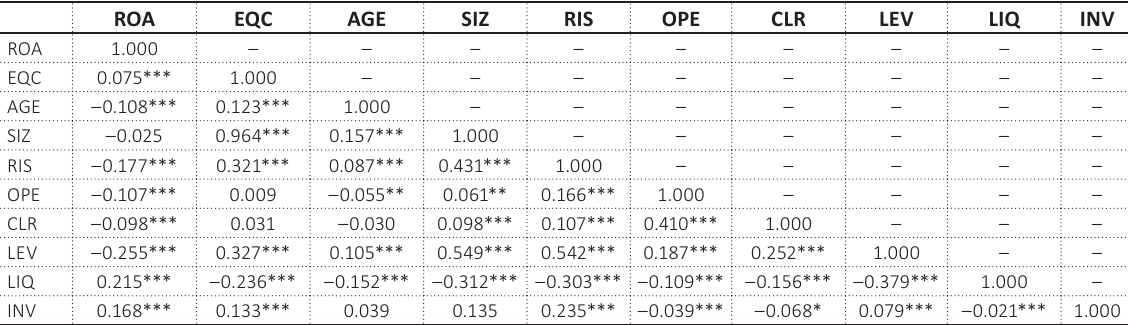
Table 3. Correlation